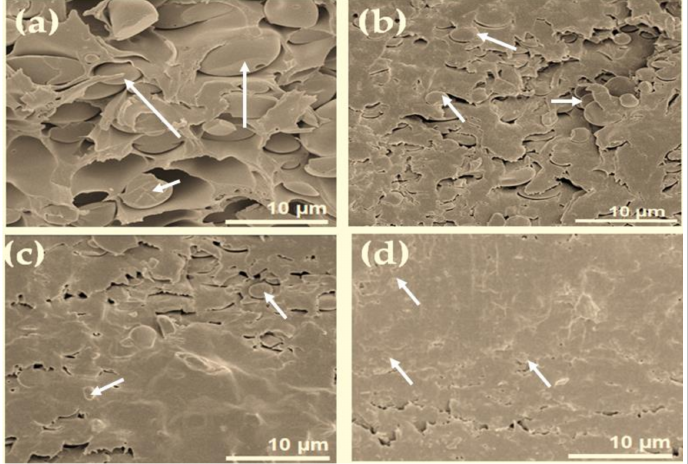
Figure 4. Cross-sectional fracture surface images of different composite samples: ( a ) PI-TSi, ( b ) PI-TSi-GPMS25, ( c ) PI-TSi-GPMS50, and ( d ) PI-TSi-GPMS75. Arrows show silica/GPMS-modified silica where the continuous matrix phase is